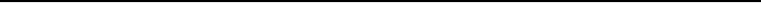
Table 1. Maximum counts of grey seal pups from field surveys using inflatable boats in breeding sites along the Norwegian coast. Approximate estimates of seals aged 1 year and older (1+) were obtained by using using the lower (4.0) and upper (4.7) multipliers. (*=Combined results from surveys conducted in 2001 and 2003) Pup Production Year Region Estimated Population